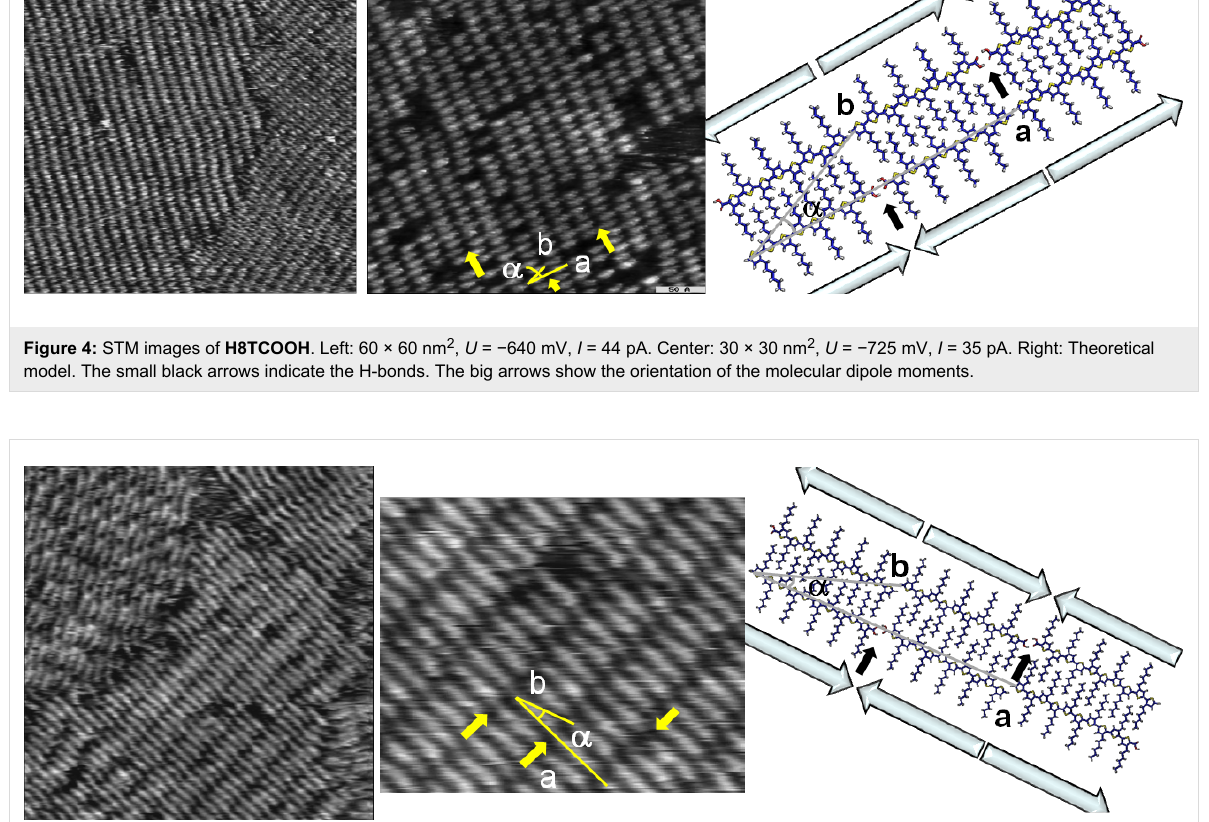
The 2-D crystal of the longest oligomer, H12TCOOH , is shown in Figure 6, left. A densely packed monolayer can be seen. One can easily recognize the molecules, which are